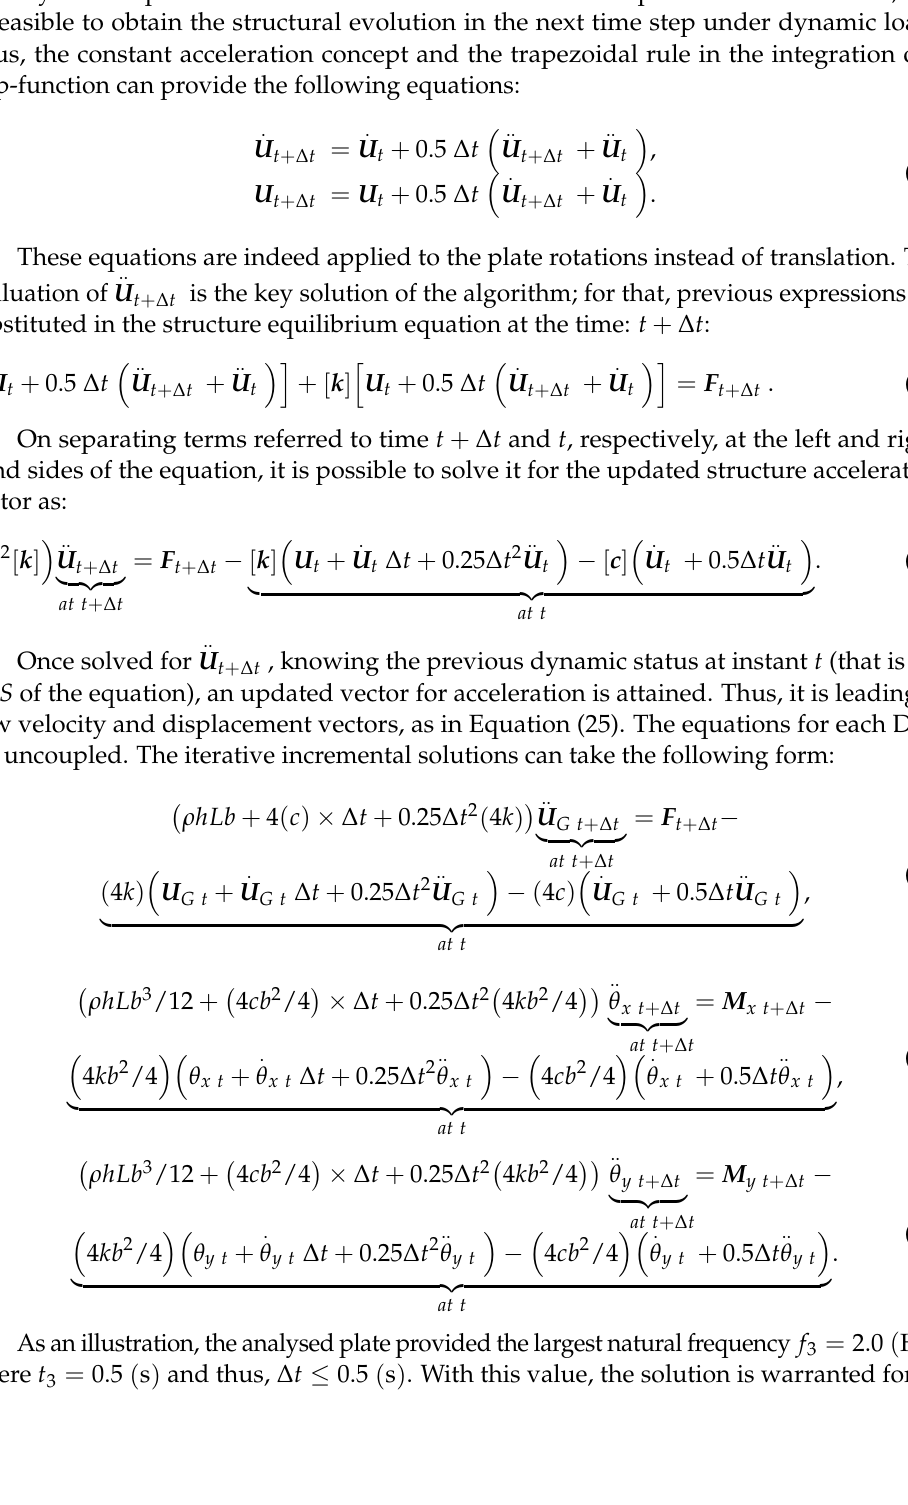
algorithm calculates the shape of a structure based on the concept of Constant Acceleration Method, where at each time step the structure’s acceleration vector is supposed to remain constant. To develop the algorithm, the structure equilibrium at an instant t + ∆ t can be formulated as follows: